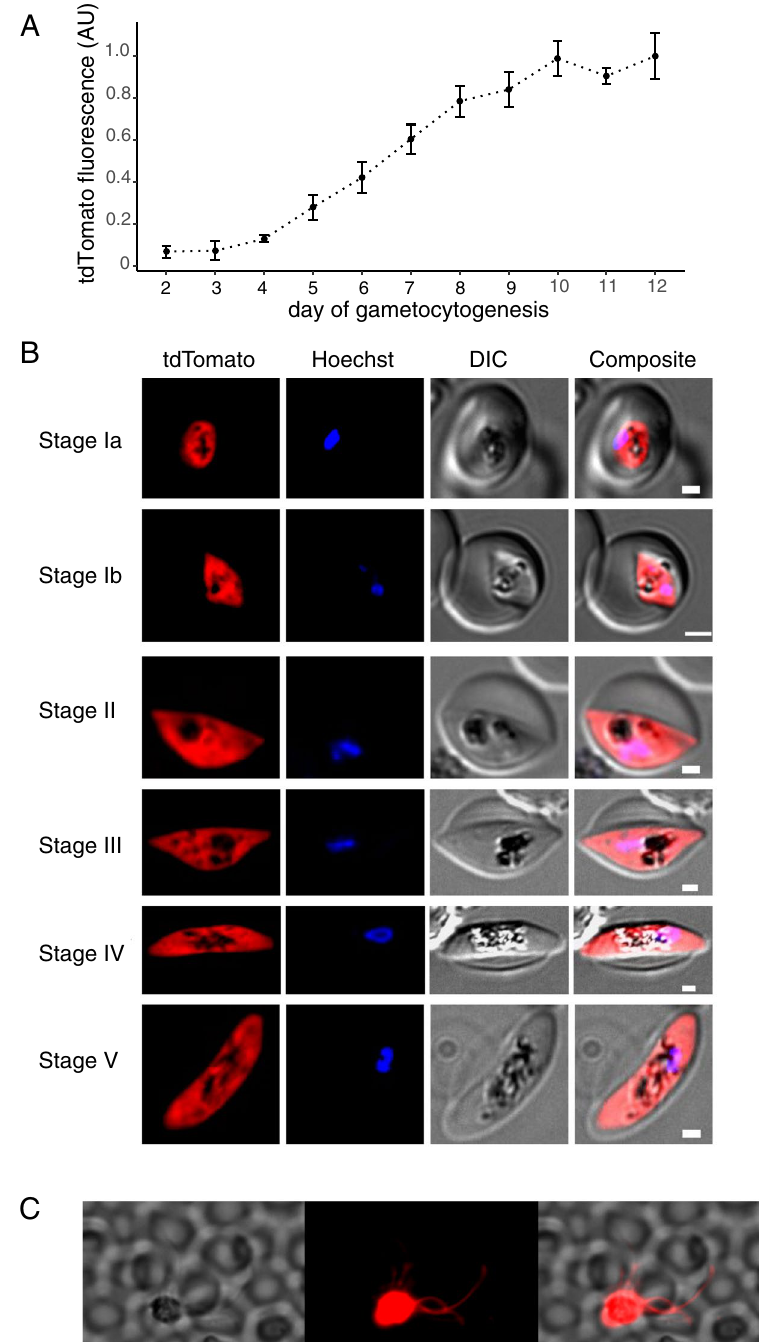
Figure 5. tdTomato expression increases throughout Pf- peg4 -tdTomato gametocyte development. ( A ) Mean fluorescence of > 1000 gametocytes was measured on days 2-12 by flow cytometry. Values are normalized to the maximum mean tdTomato signal on day 12. Mean + / − standard deviation from two independent experiments is shown. ( B ) Representative phase and fluorescence images of Pf-PEG4-tdTomato stage I-V gametocytes with the nuclear stain Hoechst 33342. Scale bar = 1 micron. ( C ) Exflagellating Pf- peg4 -tdTomato microgametes. Scale bar = 3